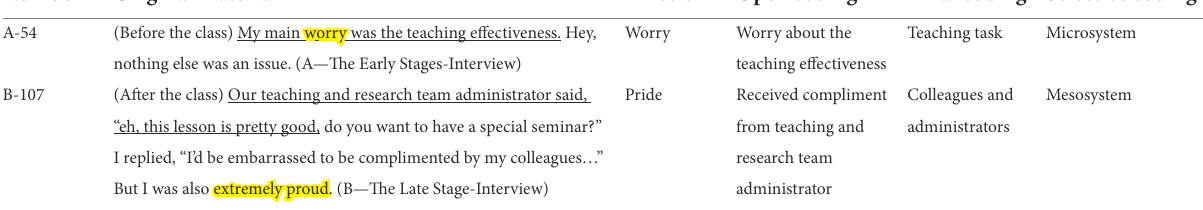
TABLE 1 A sample of data coding